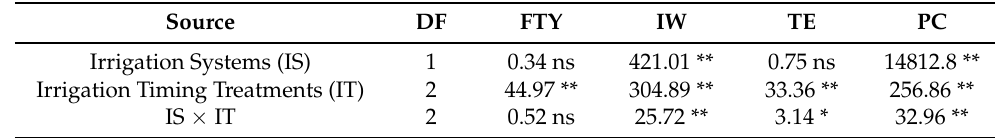
Figure 1. Total irrigated water (IW, A ), fresh tuber yield (FTY, B ), production cost (PC, C ), and total C emissions (TE, D ) with treatments under furrow (FI, red bars) and drip (DI, white bars) irrigation using timing schedule irrigation treatments: control (T1), 0.4 (T2) and 0.6 (T3) thresholds of crop water stress index (CWSI). Different letters show significant differences among timing schedule water treatments (T1-T3) under FI (lowercase letters) and DI (capital letters) using the least significant different (LSD) multiple pairwise comparison test at a 0.05 probability level based on the mixed linear model. Table 1. Variance analysis of fixed factors for agronomic (FTY—fresh tuber yield per plot and IW—total irrigated water), environmental (TE—total emissions carbon footprint), and economic (PC—production cost) indicators. F-values are presented at p < 0.01 (**), p < 0.05 (*), and p > 0.05 (ns) of significance. DF: degrees of